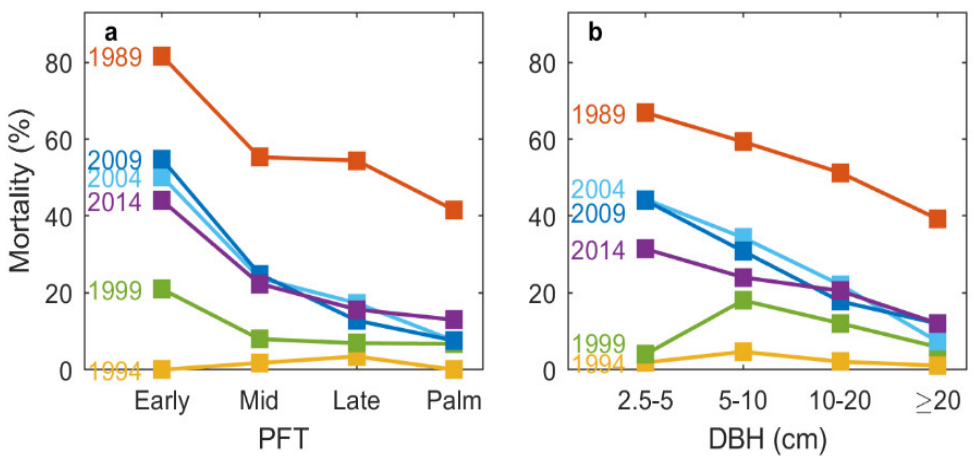
Figure 1. The mortality of ( a ) different PFTs and ( b ) different diameter (DBH) classes in each census at Bisley Experimental Watersheds, Luquillo, Puerto Rico. The mortality in 1989 refers to the immediate hurricane-induced mortality, and that in other census years refers to the mortality from the previous census year to current census year.